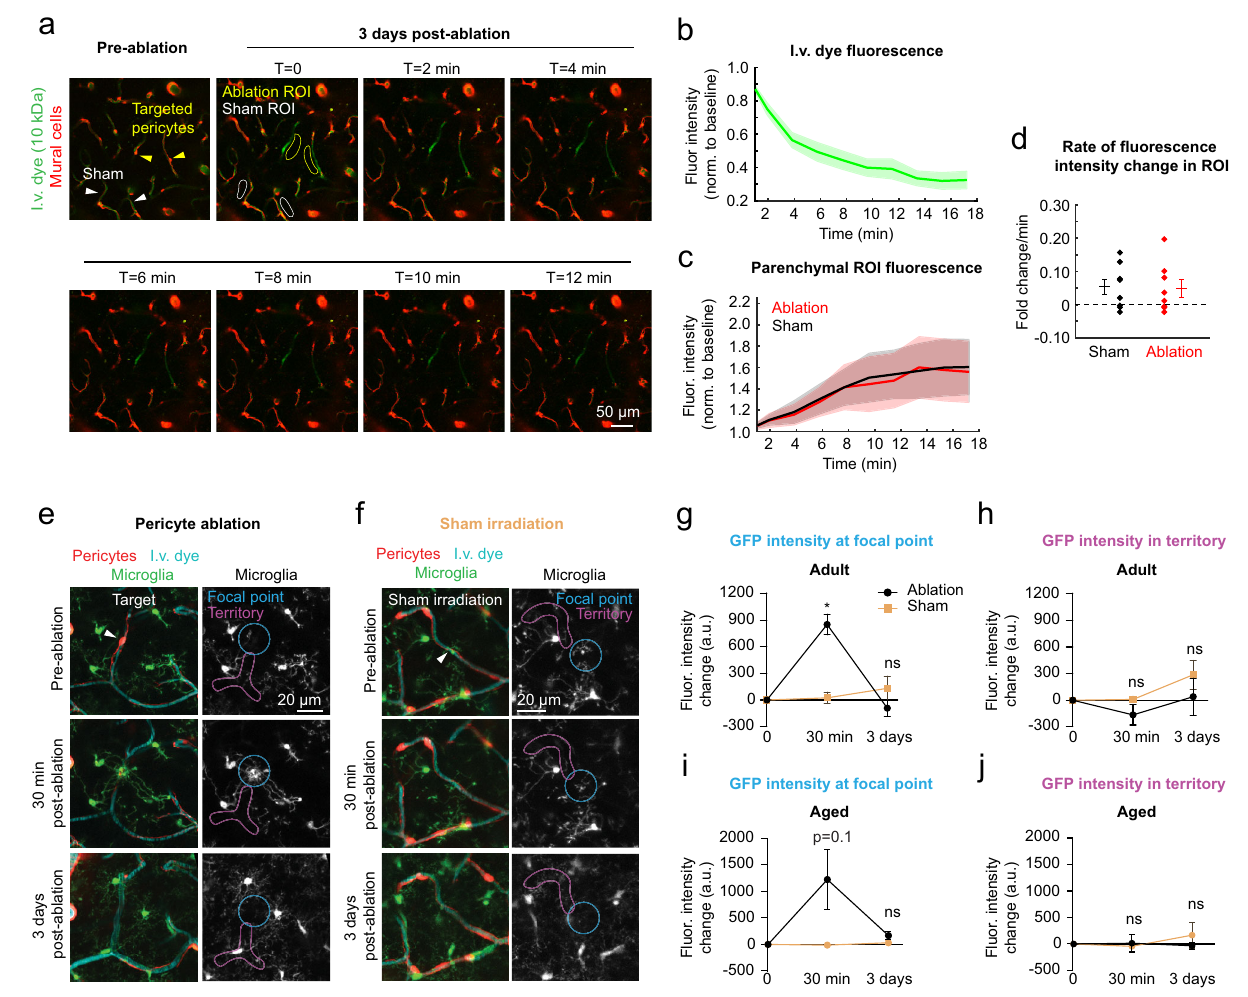
Fig. 5 | Lack of overt BBB disruption or perivascular in fl ammation with focal pericyte loss. a Imaging time course to examine for extravasation of intravenous (i.v.) 10kDa FITC-dextran dye in aged mice. Pre-ablation image shows location of targeted pericytes and sham irradiation controls. At day 3, T=0 shows regions of interest(ROI)fromwhich fl uorescenceintensitymeasurementswerecollectedover time. This is a representative example from 8 ablation experiments. b Intensity of FITC-dextran fl uorescence within the capillary lumen as a function of time post- injection. Data shown as mean±SEM. Fluor. Intensity = fl uorescence intensity. c Intensity of FITC-dextran fl uorescence in parenchymalROI between ablation and sham regions. Data are shown as mean±SEM. d Rate of fl uorescence intensity change between ablation and sham ROI regions. Wilcoxon rank sum test (two- sided), p = 0.904. N = 7 ablation regions and n =7 sham regions from 4 aged mice. Data shown as mean±SEM. In vivo two-photon images from adult Pdgfr β -tdto- mato;Cx3Cr1-GFPmice,showingmicrogliareactionto e pericyteablationor f sham